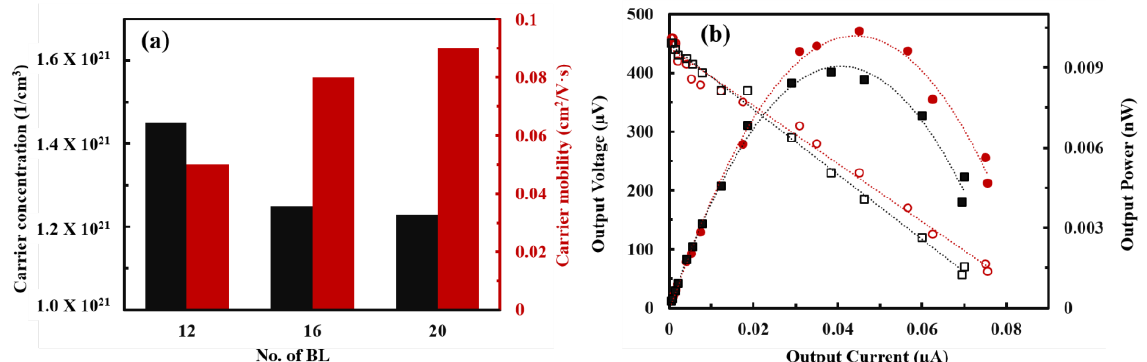
Figure 8. ( a ) Carrier concentration and carrier mobility of PANi/SWNT-PEDOT:PSS thin films assembled via spraying method as a function of bilayers deposited. ( b ) Output voltage (open symbols) and output power (closed symbols) as a function of current for 16 (squares) and 20 (circles) BLs PANi/SWNT-PEDOT:PSS prepared with spraying